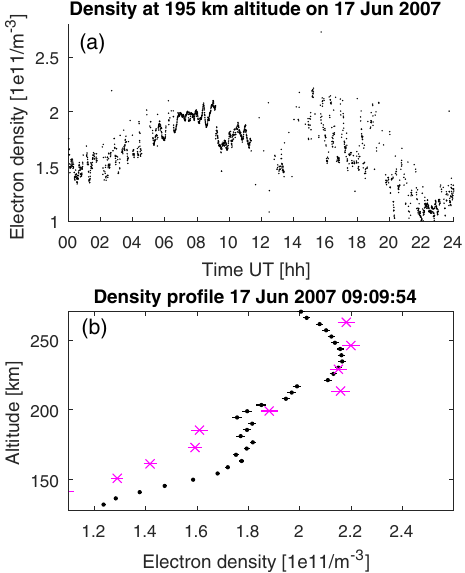
Figure 4. (a) Plasma density recovered from plasma line data us- ing 30s integration (black points). (b) Electron density profile from plasma line data (black) and from 60s integrated ion line data (pink